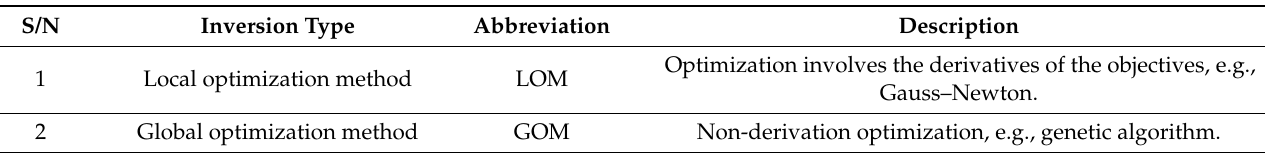
Figure 2. Flowcharts of the proposed combined local and global optimization algorithm. Table 1. A summary of all the types of inversion applied in this study, their description, and abbreviations are presented